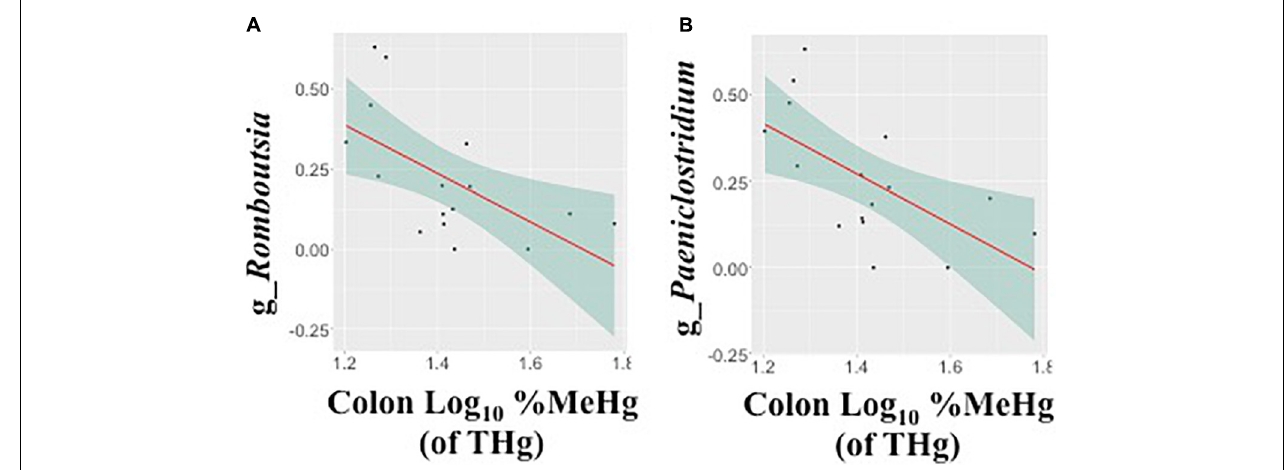
FIGURE 4 | Associations between the relative abundance of gut microbiota amplicon sequence variants (arcsine-square root transformed) and colon %methylmercury (MeHg) [of total mercury (THg)] (log 10 -transformed), including (A) genus Romboutsia (family: Peptostreptococcaceae ) and (B) genus Paeniclostridium (family: Peptostreptococcaceae ) ( n = 16 walruses). Each plot includes the linear regression line ± standard error of the regression line (see Table 4